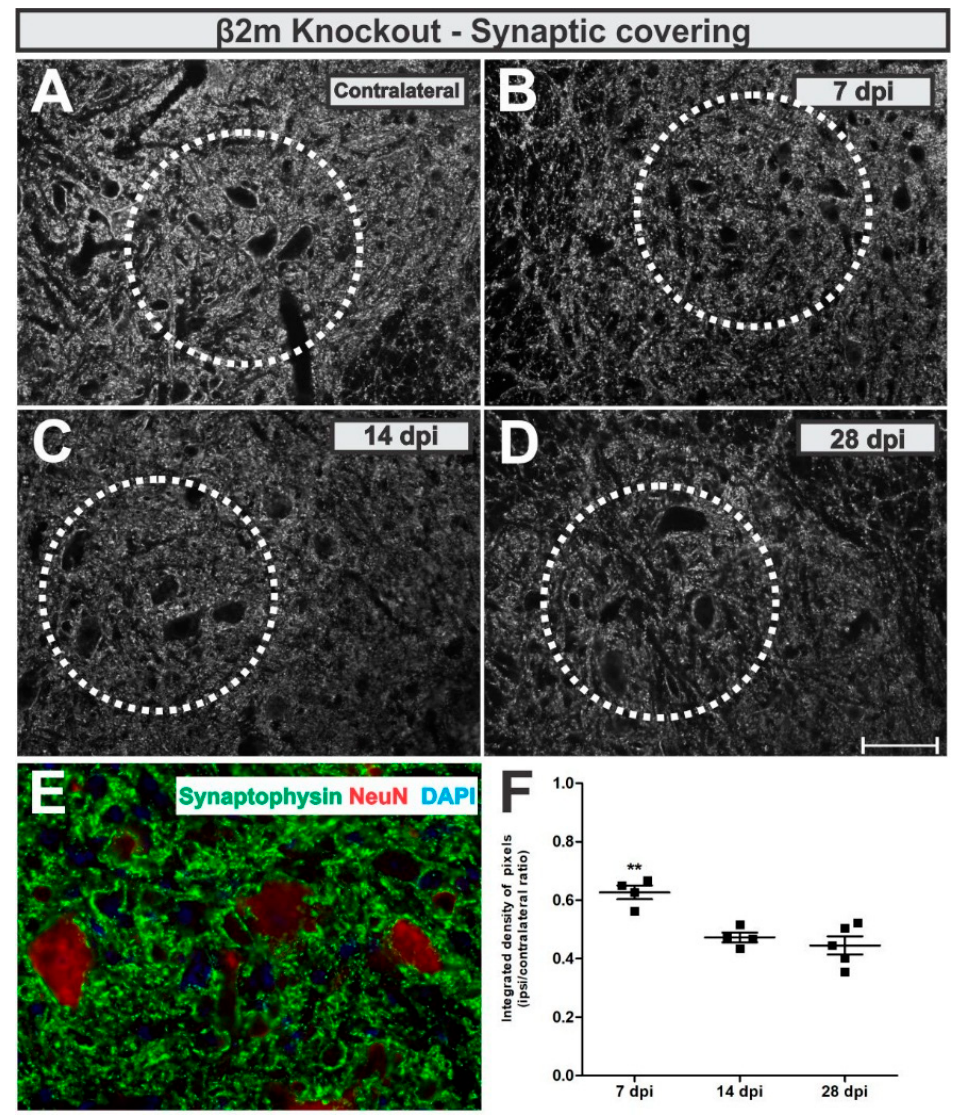
Figure 8. Synaptic covering in β 2m knockout mice. ( A ) representative contralateral image, ( B ) 7 dpi, ( C ) 14 dpi and ( D ) 28 dpi. ( E ) illustrates the synaptic inputs (in green) to ipsilateral motoneuron-like cells, labelled with NeuN (in red). ( F ) Comparative quantification among time points (ipsi/contralateral ratio); p < 0.01 (**). Scale bar = 50 μ m.